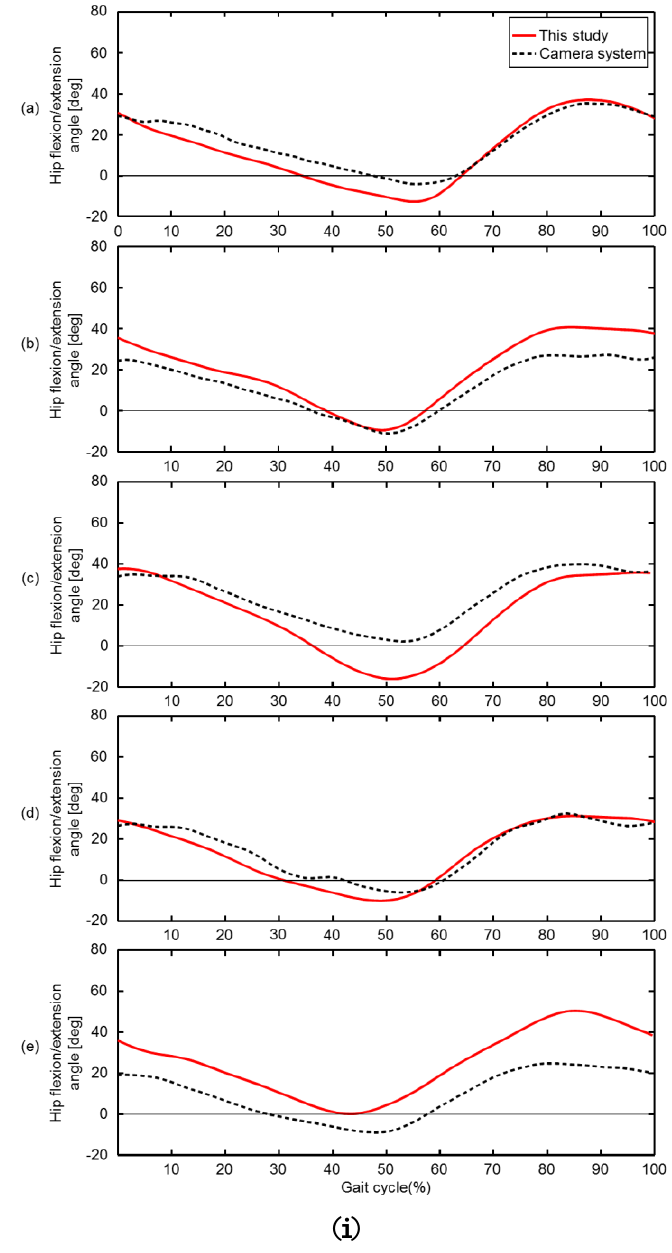
Figure 6. Comparison of the hip flexion/extension angle ( i ), the knee flexion angle ( ii ) and ankle dorsi/plantar flexion angle ( iii ) during one gait cycle for volunteers (a–e). The red line is the result obtained from this study and the dotted line is the results from the camera. For (i) and (ii) the vertical axis shows the flexion/extension angle, where 0 is the angle in the upright position and flexion is positive. For (iii) the vertical axis shows the dorsi/plantar flexion angle, where 0 is the angle in the upright position and dorsiflexion is positive. The horizontal axis shows the percentage of one gait